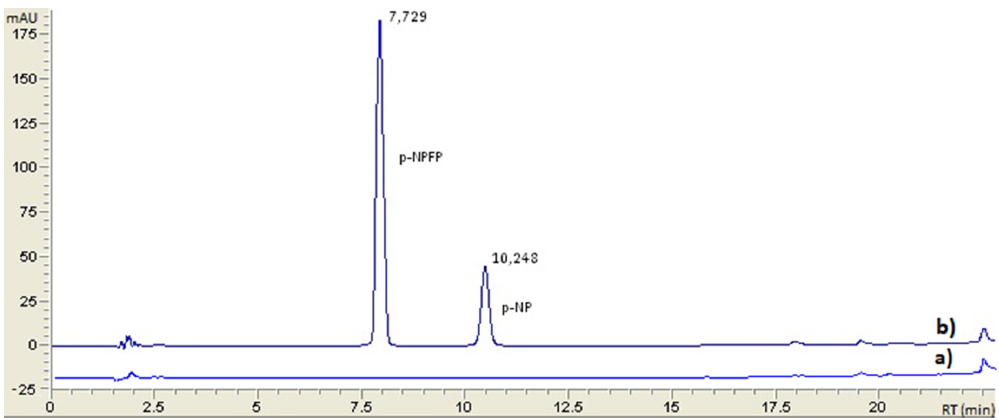
Figure 1. RP-HPLC evaluation of α -l-fucosidase activity in Fiore Sardo PDO (protected designation or origin) sheep’s cheese. ( a ) Chromatogram of the blank; ( b ) chromatogram of a real sample (RC, February, after 105 days of ripening). Peak 1, p-nitrophenyl- α -l-fucopyranoside, p -NPFP; peak 2, p -nitrophenol, p -NP.